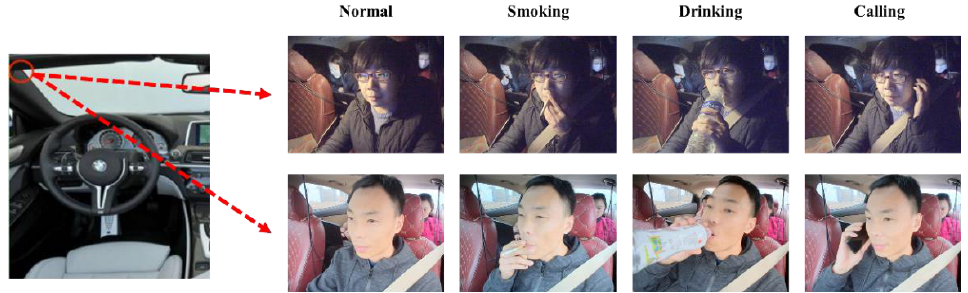
Figure 7. Camera deployment location and four categories of driving status.